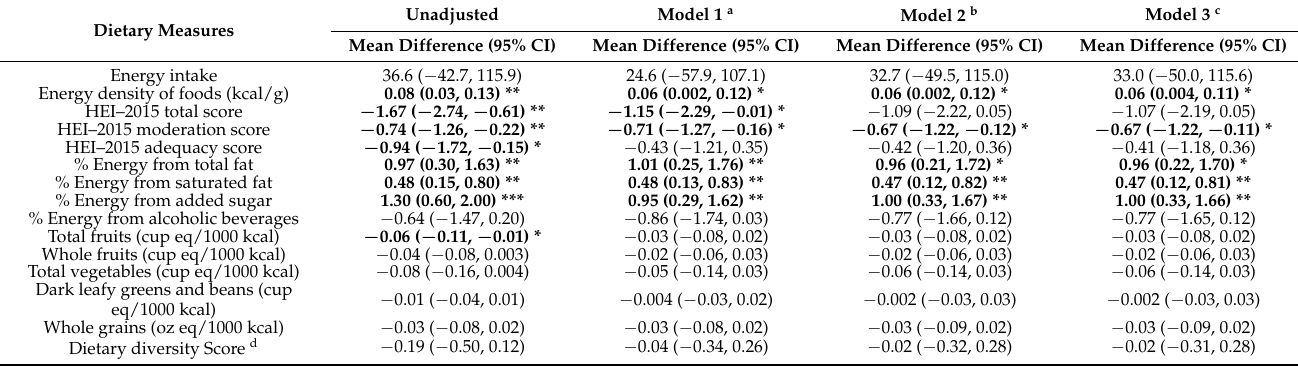
Table 3. Associations between self-reported olfactory function and dietary measures among NHANES 2011-2014 partici- pants, ages 40 years and older, tested in survey-weighted regression models. Dietary